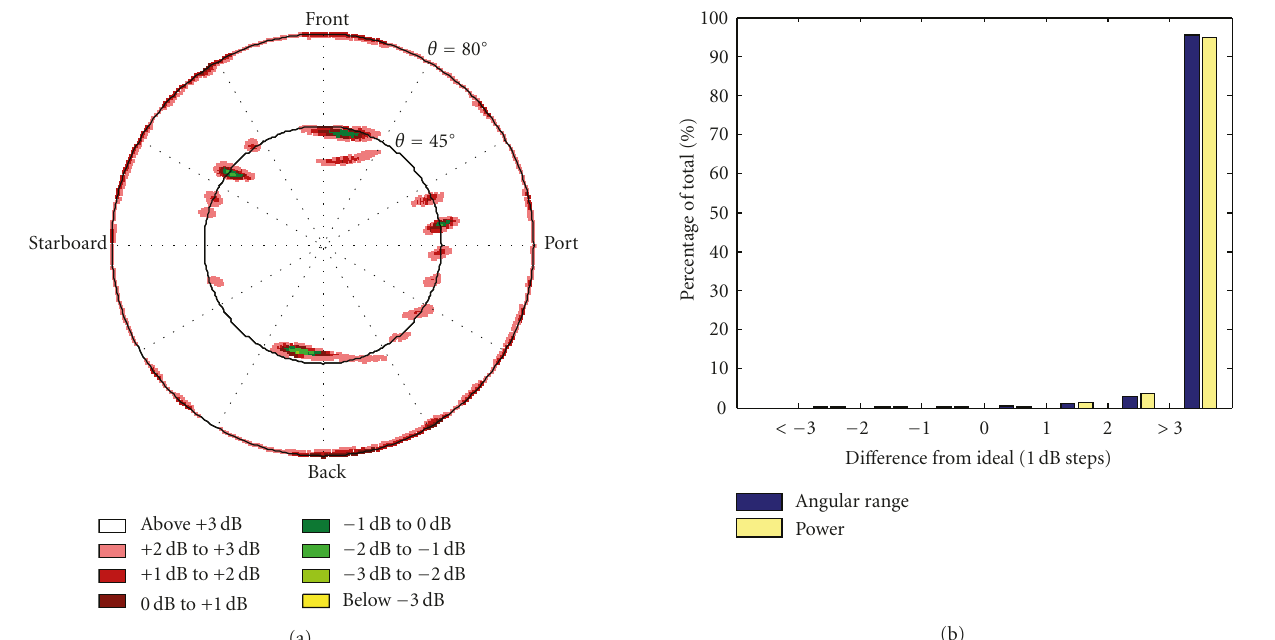
Figure 13: Assessment of helical antenna radiation pattern on the gondola with plastic ground handling bars normalised to θ = 80 ◦ minima; (a) flattened hemisphere plot of gain comparison to ideal radiation pattern shape, (b) radiation pattern power distribution in relation to ideal radiation pattern shape, from FEKO.